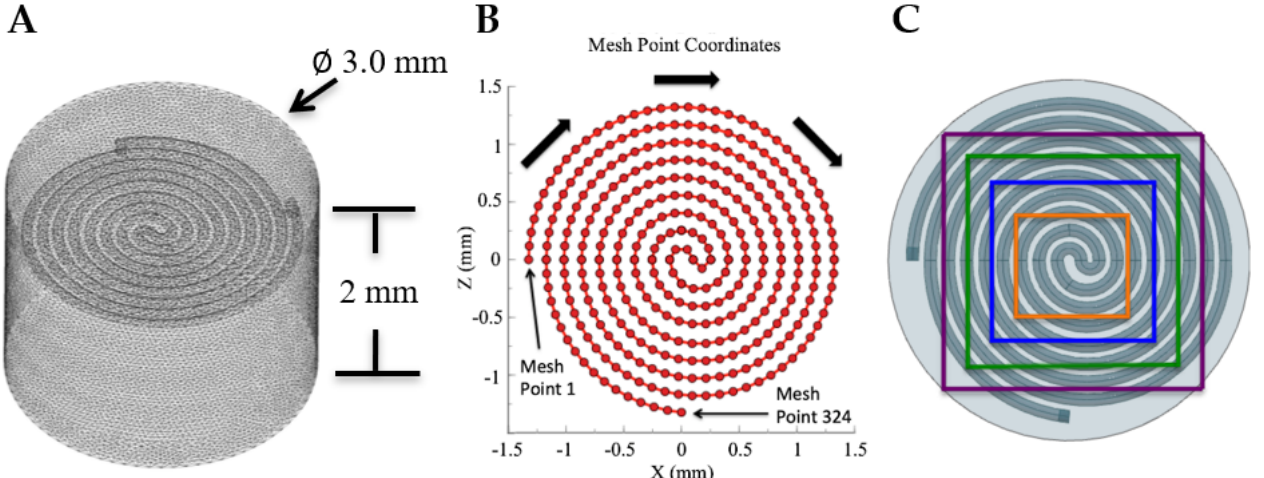
Figure 3. ( A ) A 0.05 mm triangular mesh size was used to characterize the soft sensor using finite element analysis via Matlab’s FEAtool application. ( B ) A 2D graphical depiction of the mesh point locations that were used to model the deformation of the liquid metal channel. The first recorded point begins at the leftmost point of the spiral structure and follows the arrows around the structure until it reaches the final mesh point at the bottommost point of the channel. ( C ) Areas outlined by the color-coded squares represent the area under compression during pressure directionality testing.